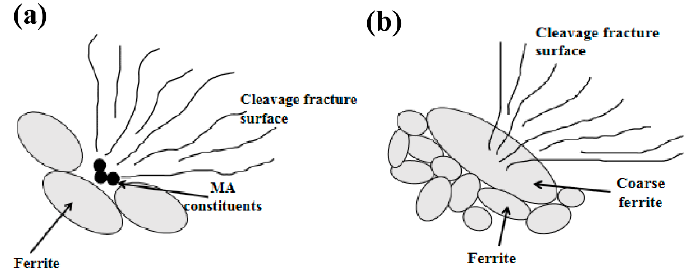
Figure 16. Schematic diagrams showing fracture processes for ( a ) as-welded impact specimen and ( b ) for PWHT impact specimen.